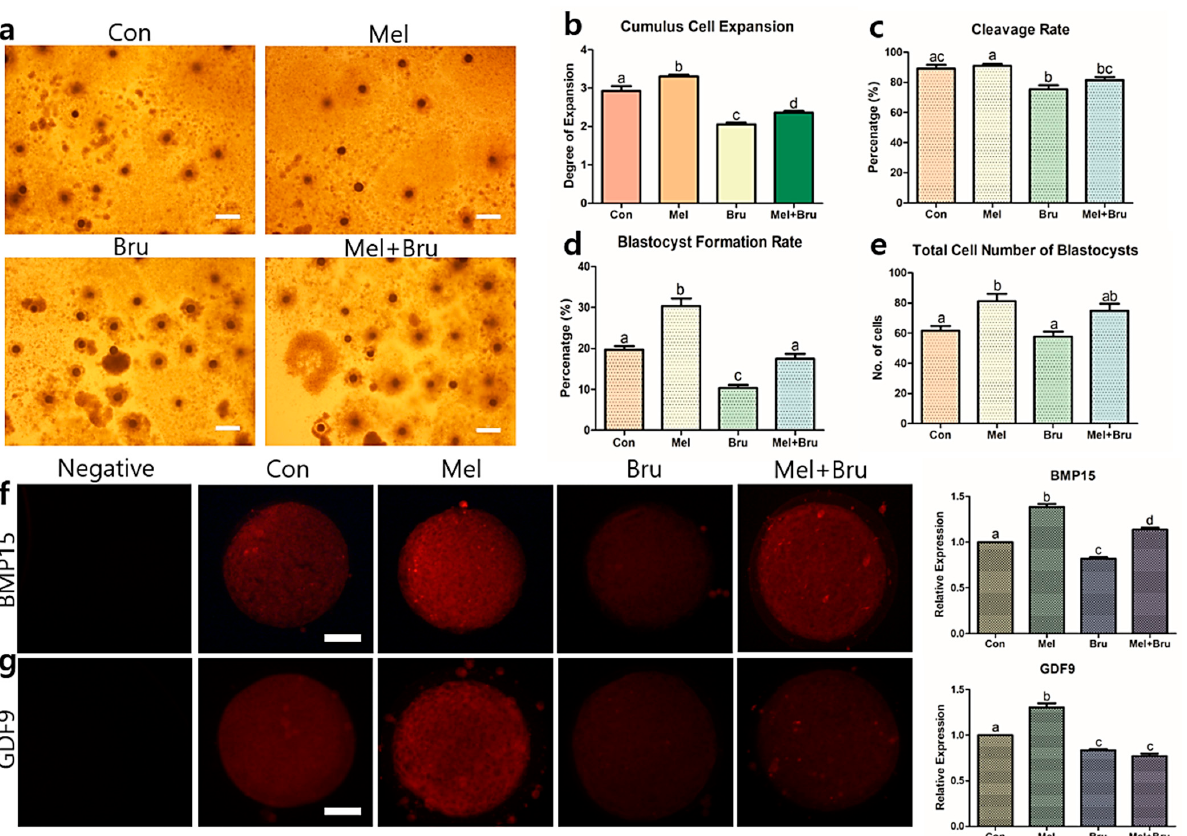
Figure 2. Evaluation of treatments with melatonin and brusatol on porcine COCs and their competences. With the treatment of 10 − 9 M melatonin and 12 nM brusatol, their e ff ects on the CC expansion and subsequent embryonic development were evaluated. The four experimental groups (control, melatonin, brusatol, and co-treatment) showed distinct di ff erences in ( a , b ) the CC expansion, ( c ) cleavage rate, ( d ) blastocyst formation rate, and ( e ) total cell number. Additionally, protein expressions related to competence of the porcine COCs from each experimental group were evaluated by immunocytochemistry. The protein expression levels in ( f ) BMP15 and ( g ) GDF9 showed significant di ff erences among the groups. Bars with letters indicate significant di ff erences ( p < 0.05). 20 × magnification, bars indicate 300 µ m in Figure 2a and 400 × magnification, bars indicate 30 µ m in Figure 2f,g. At least three replicates were performed for each experiment.